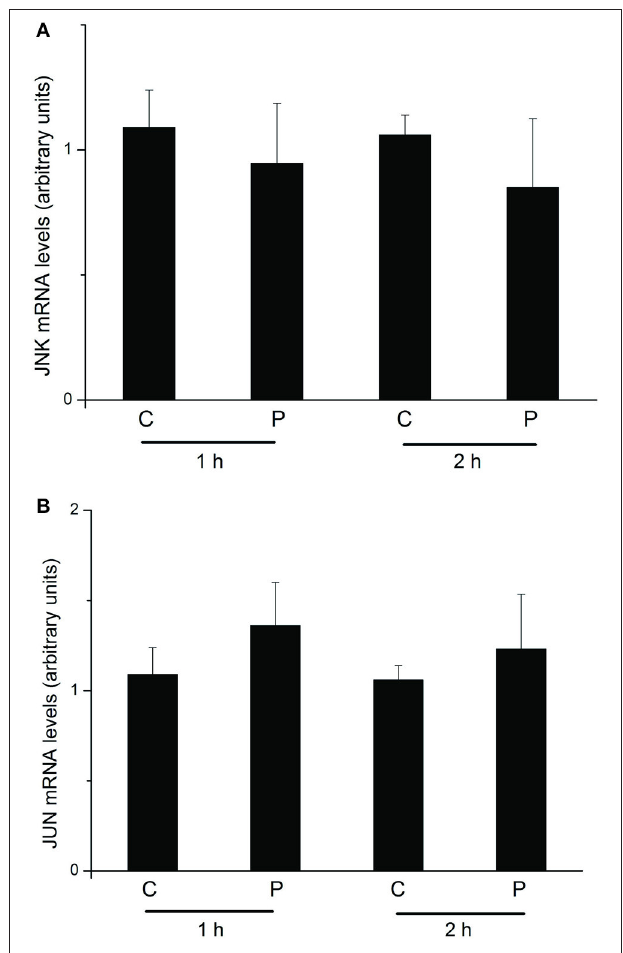
FIGURE 8 | Changes in mRNA expression levels of JNK (A) and Jun (B) upon treatment with the PTTH . PGs were preincubated in medium for 30min and then transferred to medium containing the PTTH (P) or control medium (C). Incubation was maintained for 1 and 2h. After each incubation, total RNA was extracted from PGs, and mRNA expression levels of JNK and Jun were determined by an RT-qPCR. Each bar represents the mean ± SEM of four separate